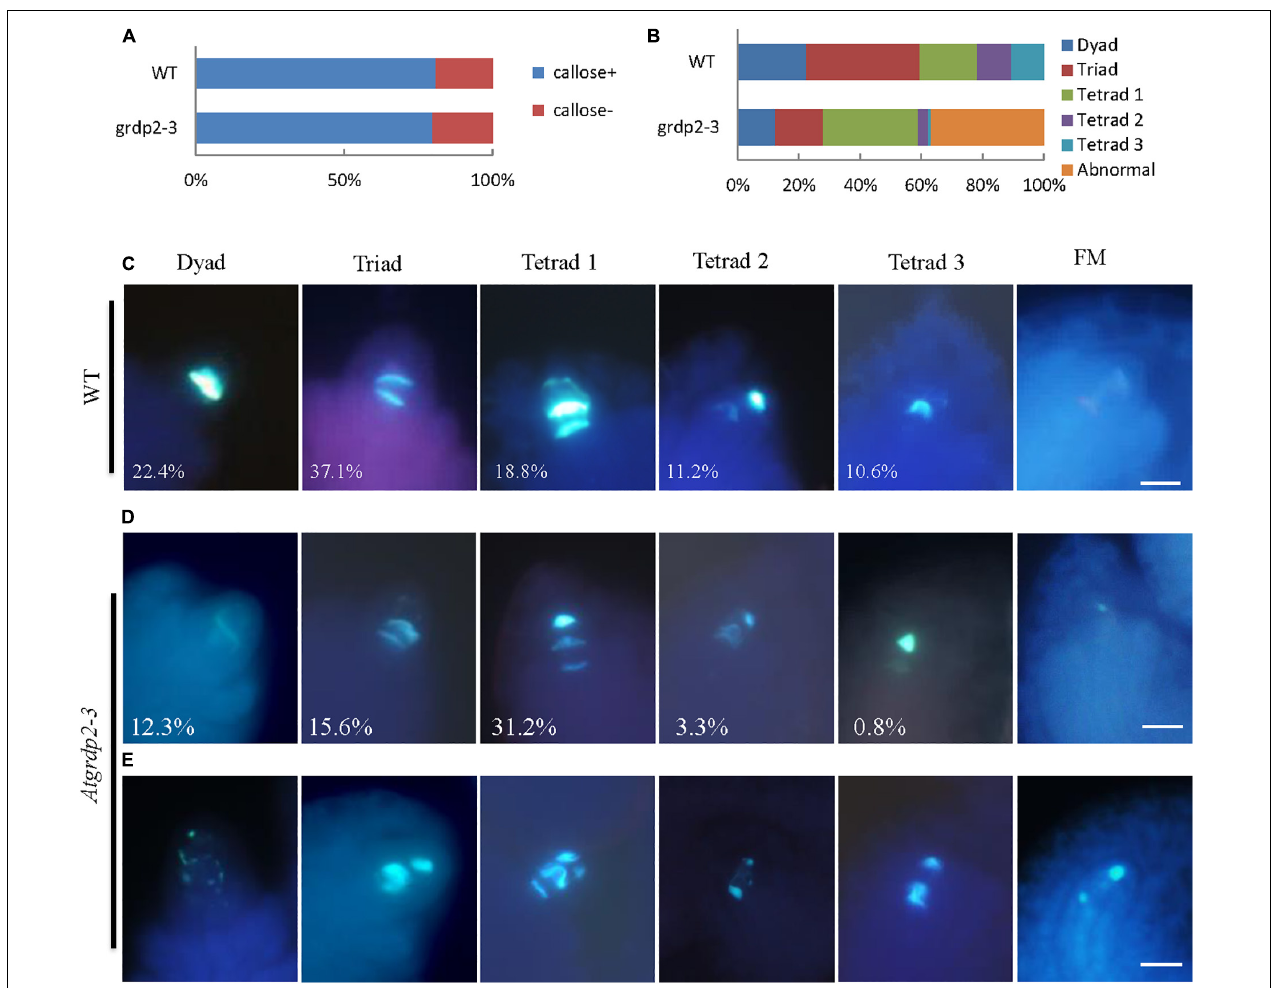
FIGURE 5 | Callose deposition during megasporogenesis are defective in grdp2-3 mutant ovules. (A) Quantification of callose staining-positive (+) and callose staining-negative (–) ovules at stage 2IV in more than 100 ovules for each sample. (B) Quantitative profile of callose deposition at various stages of meiosis in more than 100 ovules for each sample. (C) Callose-stained wall deposition in WT ovules at stage 2IV. (D) Callose-stained wall deposition in grdp2-3 ovules at stage 2IV. (E) Abnormal callose staining is observed in grdp2-3 ovules during